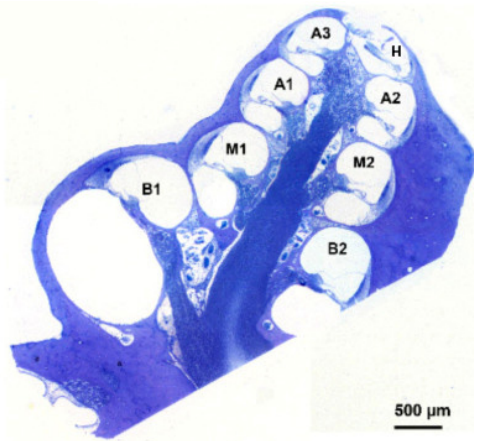
Figure 2. Representative cochlear cross-section. The image is representative of a cochlear midmodiolar section in which all the cochlear locations have been indicated by appropriate lettering: B1, B2, M1, M2, A1, A2, A3, H. The image has been modified from Vink et al., 2020 [15]. Table 1. Criteria for the identification of specific sensory and non-sensory cells of the organ of Corti. For each cell type, morphological aspects for their identification were determined and used to perform the cell count along the cochlear turns.